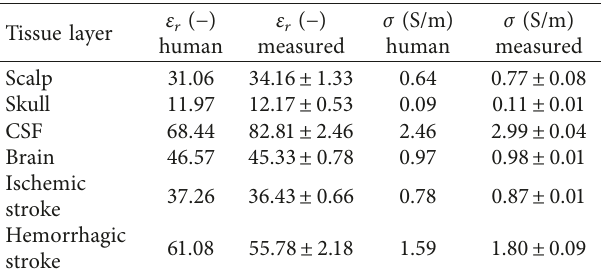
Table 4: Dielectric properties at 1GHz of the different tissue- equivalent layers of the human head phantom for stroke